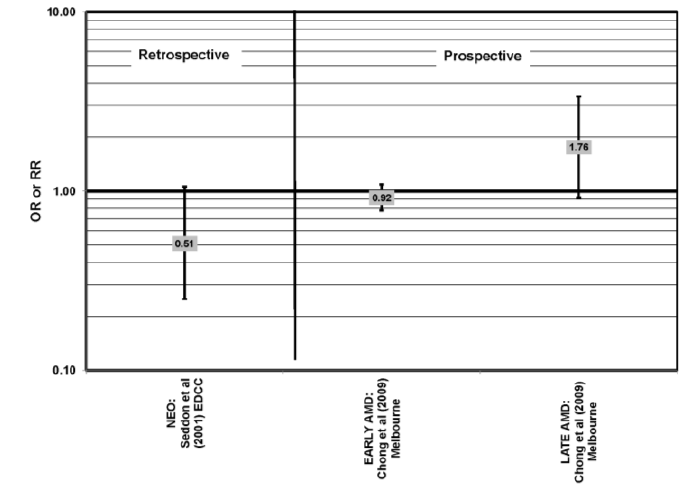
Figure 20. Odds or risk ratio for late AMD or neovascular AMD (NEO); high vs. low intake trans-fatty acids: retrospective and prospective